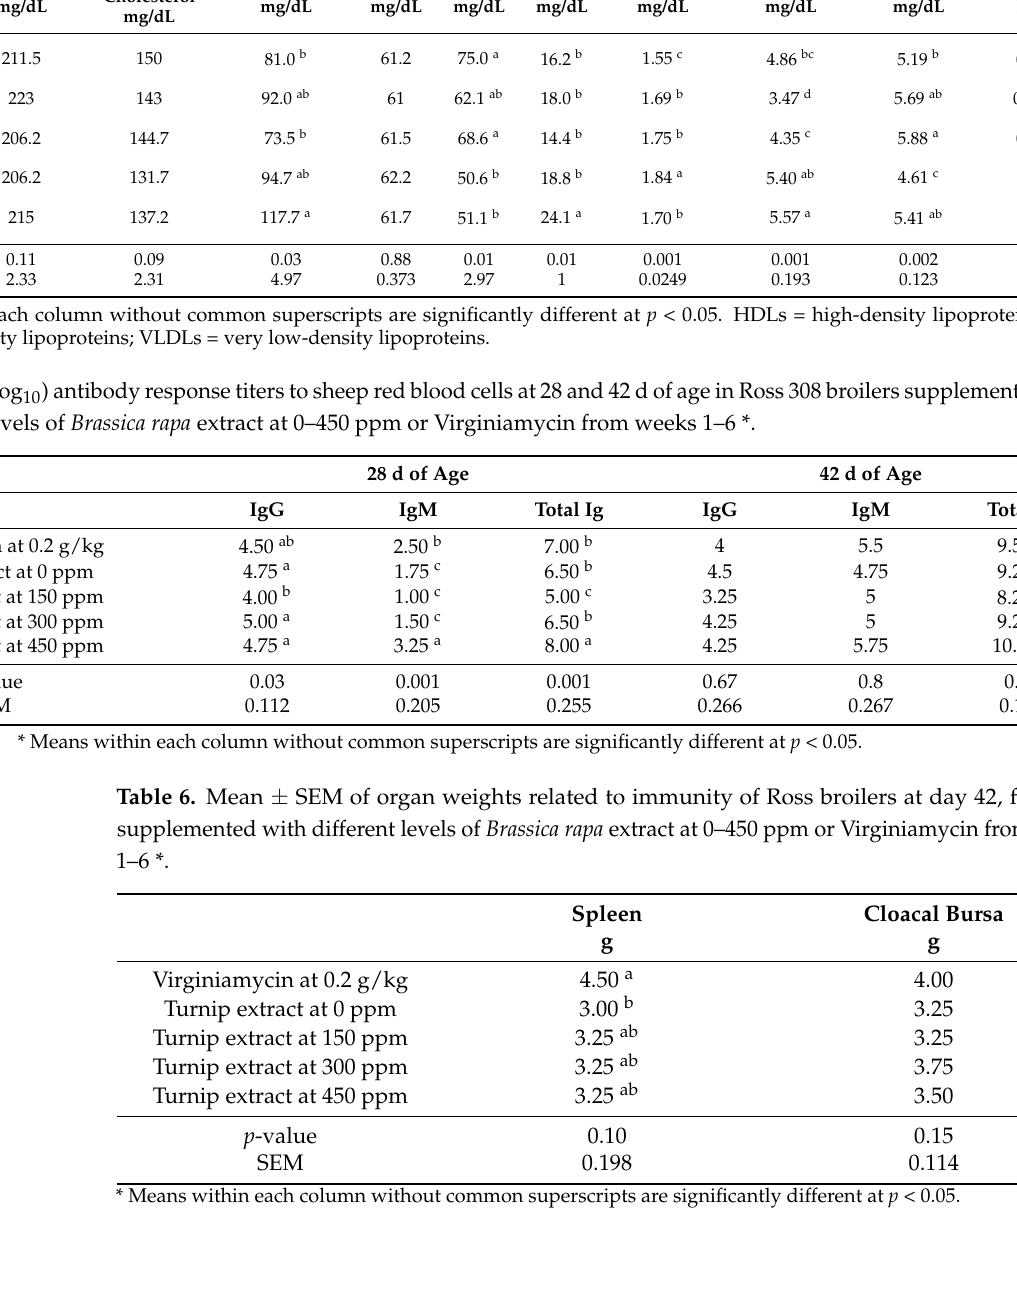
treatment effects on the weight of the cloacal bursa (Table 6). Coliform bacteria were more numerous in the Virginiamycin treatment and least in the 450 pm treatment. The cecal Gram-negative lactose bacteria were greatest for the 0 ppm treatment, tended to decline with increased turnip extract and were least in the Virginiamycin treatment (Table 7). Table 4. Mean ± SEM of blood serum parameters at 42 d of age in Ross 308 broilers supplemented with different levels of Brassica rapa extract at 0–450 ppm or Virginiamycin from weeks 1–6 *. Total Glucose Cholesterol mg/dL mg/dL Virginiamycin at 0.2 g/kg